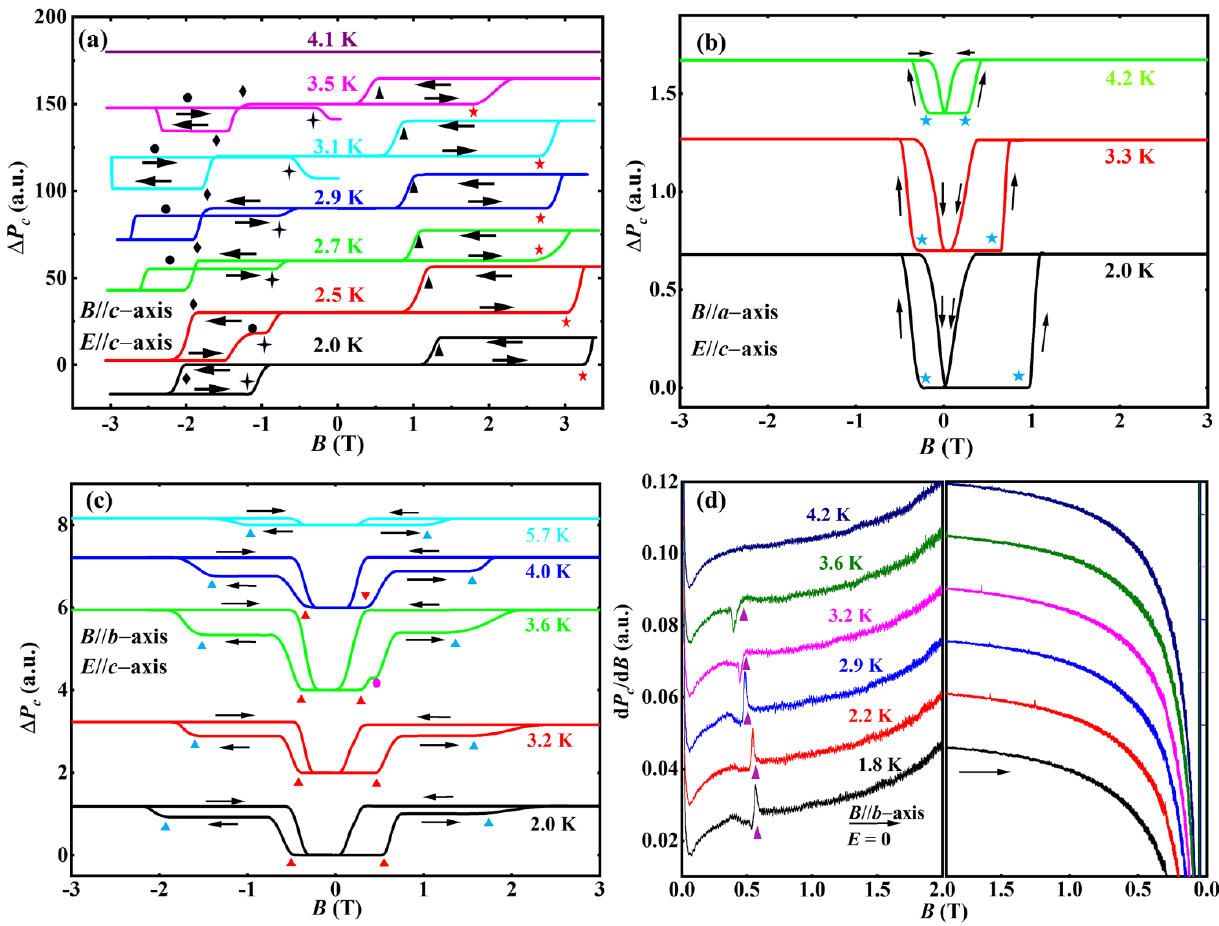
Figure 5. ( a – c ) Electric polarization as a function of pulsed magnetic fields, measured under the pulsed magnetic field along c -axis ( a ), a -axis ( b ), and b -axis ( c ), where the electric fields ( E = 1.5 kV/cm) are along c -axis. ( d ) The magnetic field dependence of d P c /d B measured at various temperatures with the applied pulsed magnetic field along b -axis and E = 0. The curves are offset for clarity. The various symbols of red pentacle, black triangle, black diamond, cross, solid circle, blue pentacle, red triangle, and purple triangle represent the transitions in the curves. The sweep directions of the magnetic field are labeled by black arrows.